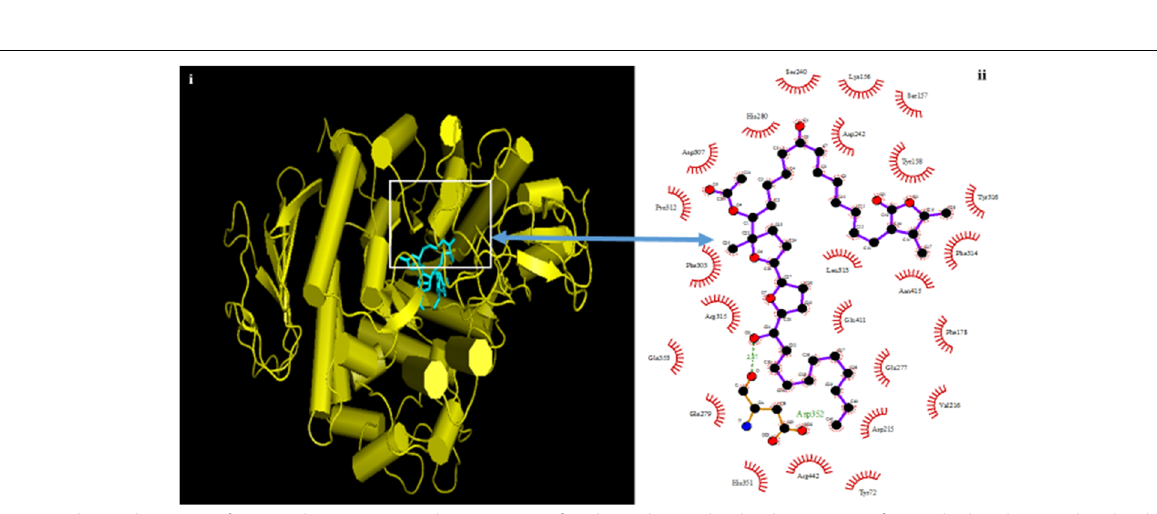
Fig. 18 The Binding pose of 15-acetyl guanacone at the active site of α -glucosidase with a binding energy of − 7.00 kcal/mole (i), and molecular interaction of 15-acetyl guanacone with amino acid residues within the active site of α -glucosidase